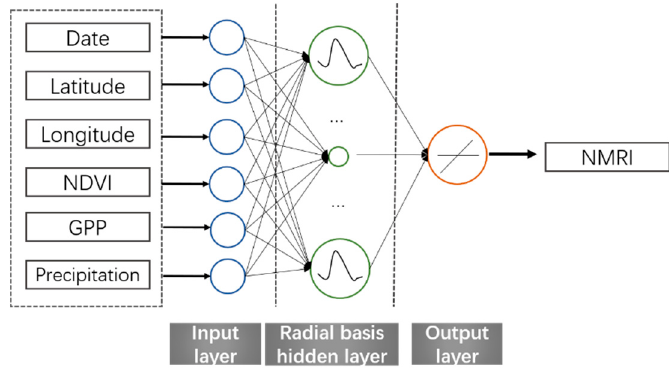
Figure 3. Structure of Generalized Regression Neural Network (GRNN).